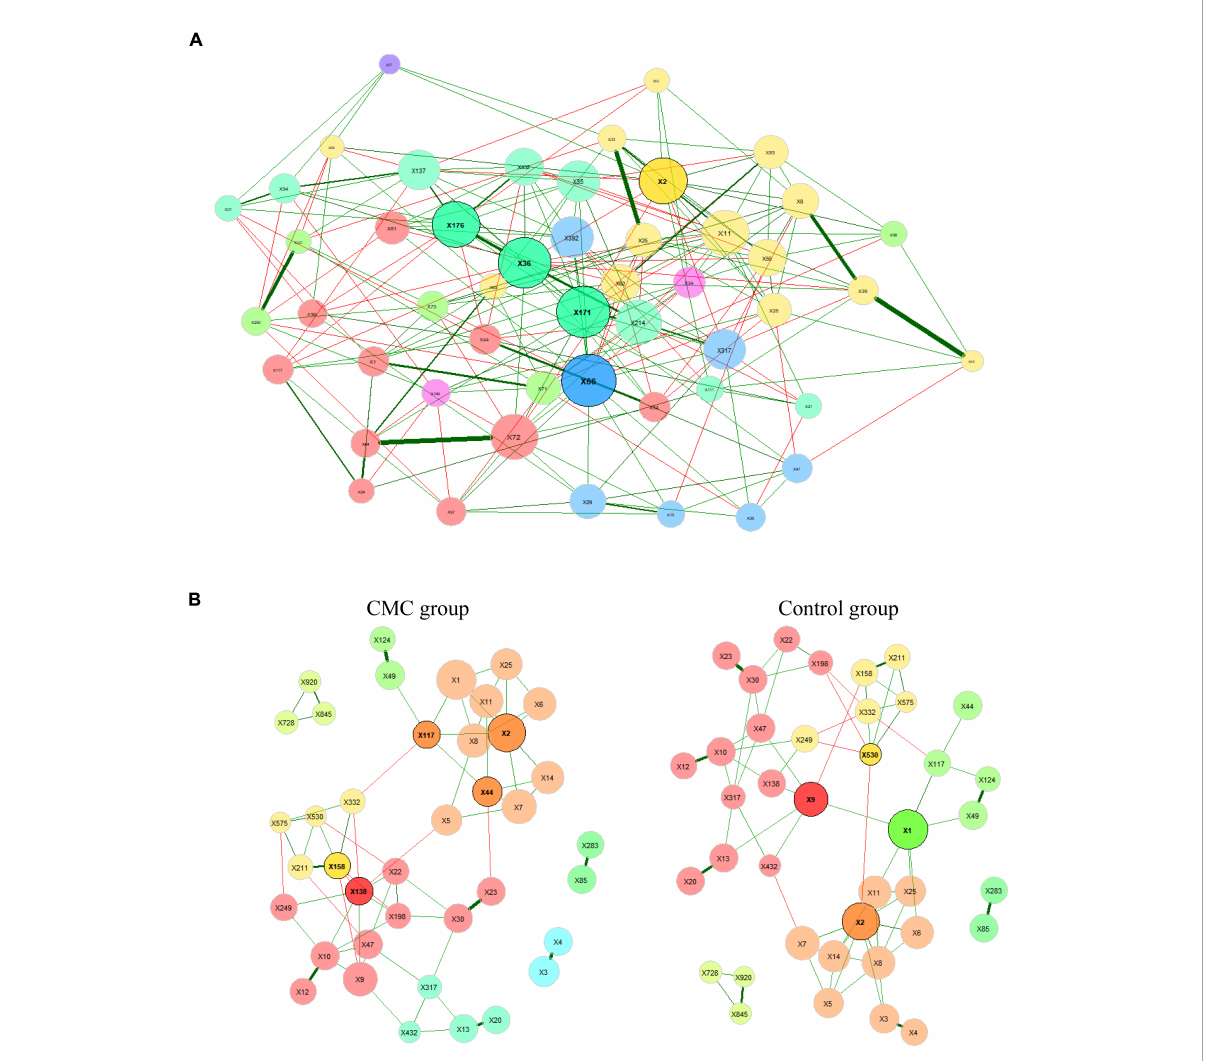
FIGURE5 Bacterial associations of samples in two groups. The SPRING method is used as an association measure. The estimated partial correlations are transformed into dissimilarities via the “signed” distance metric and the corresponding (non-negative) similarities are used as edge weights. Green edges correspond to positive estimated associations and red edges to negative ones. Eigenvector centrality is used for defining hubs (nodes with a centrality value above the empirical 95% quantile) and scaling node sizes. Hubs are highlighted by black borders. Node colors represent clusters, which are determined using greedy modularity optimization. The 100 most abundant taxa were analyzed in this part and (A) the complete association network where the 50 nodes with the highest degree are shown. (B) Comparison of bacterial associations in two groups. Centrality and clustering measures are adopted from the complete network. Species represented by the nodes are given in Supplementary Table 5